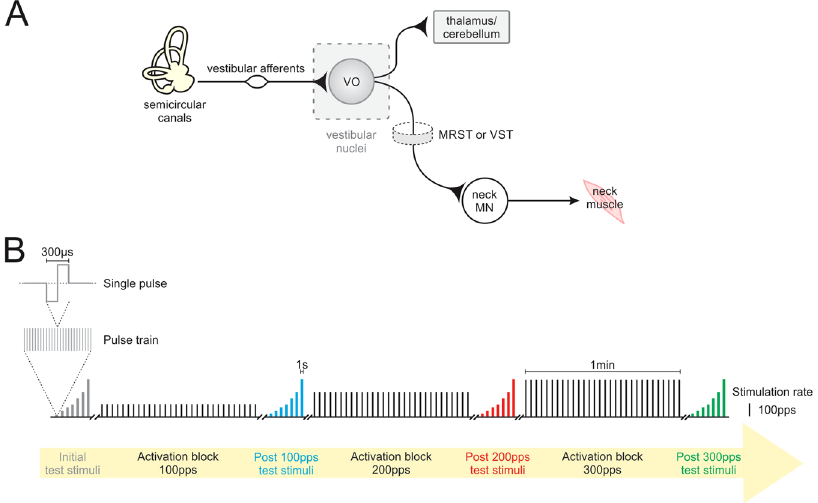
Figure 1. Vestibulo-collic reflex pathway and stimulation protocol. ( A ) Diagram of pathways mediating the vestibulo-collic reflex. MN, motoneurons; MRST, medial reticulospinal tract; VST, vestibulospinal tract. ( B ) Timeline of stimulation protocol. Each rectangle represents a pulse train in which the width represents the duration and the height represents the pulse rate. Test stimuli consisted of pulse trains lasting 1 s delivered at rates of 25–300pps. Activation stimuli consisted of 30 pulse trains lasting 500 ms delivered every 2 s at pulse rates of 100, 200 and